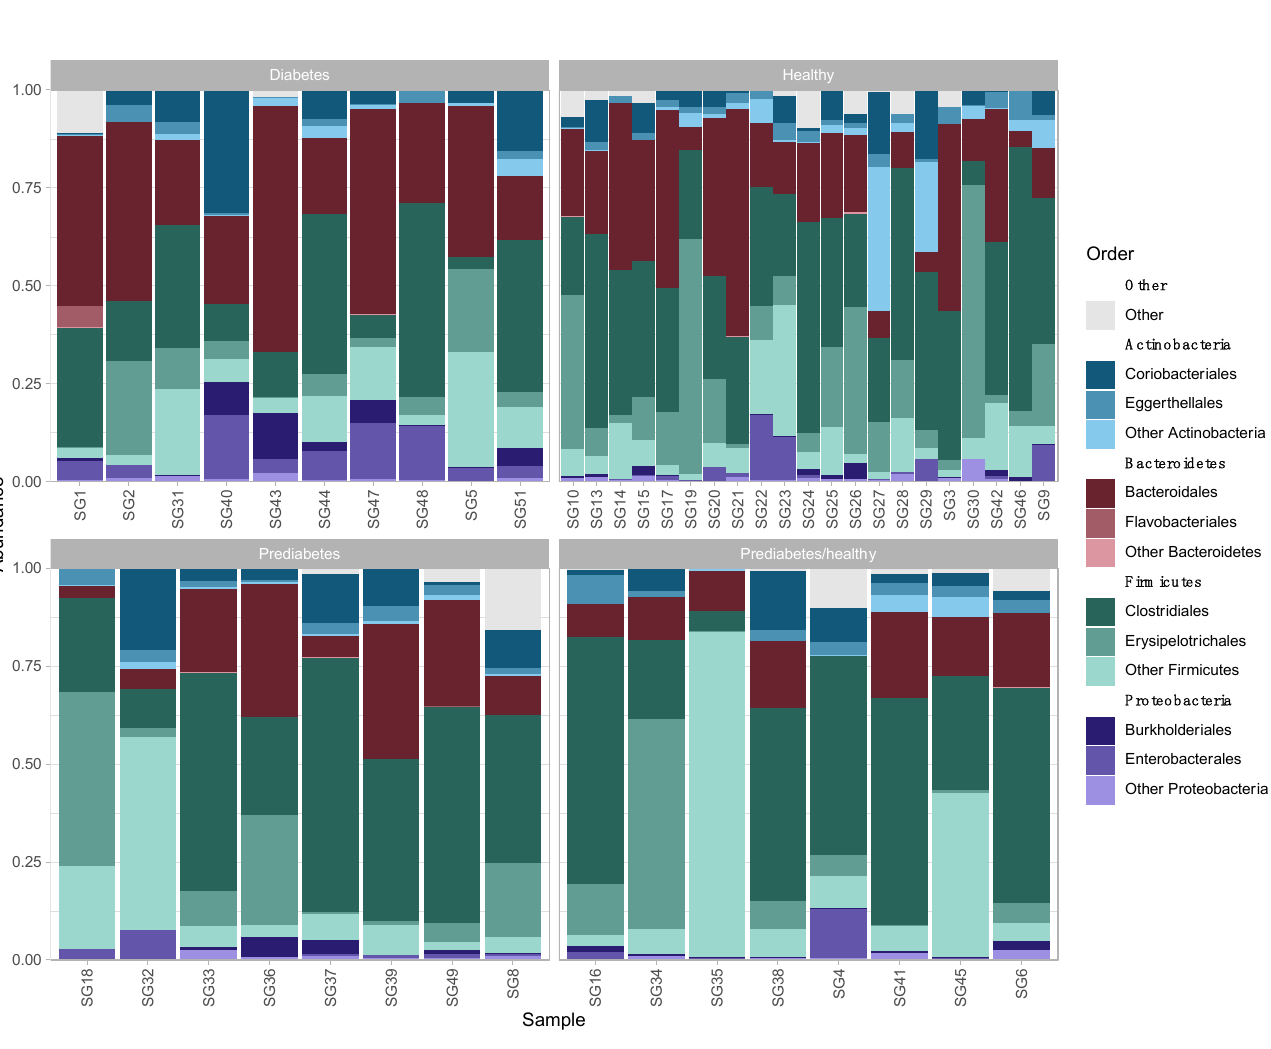
Figure 1. Relative abundance of the three most abundant bacterial orders within each of the four most abundant phyla in fecal microbiota of patients by health status.